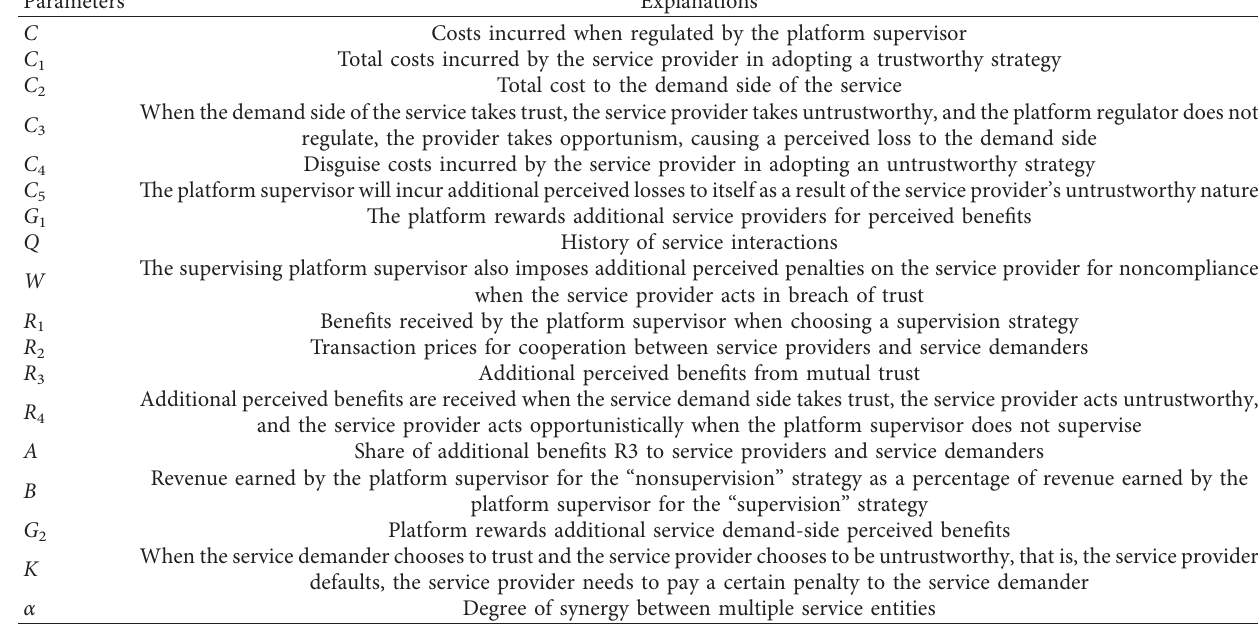
Table 1: Tripartite evolutionary game model parameters of service demander, service provider, and platform supervisor. Parameters